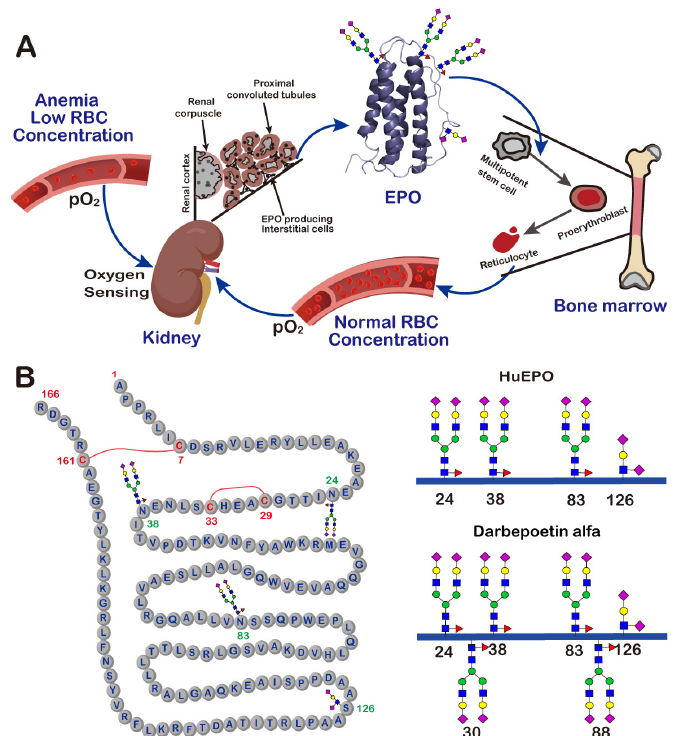
Figure 2. The production, function and structure of EPO. ( A ) A schematic view of the feedback loop mechanism of EPO production and function. ( B ) The amino acid sequence and glycan structures of different EPO variants.